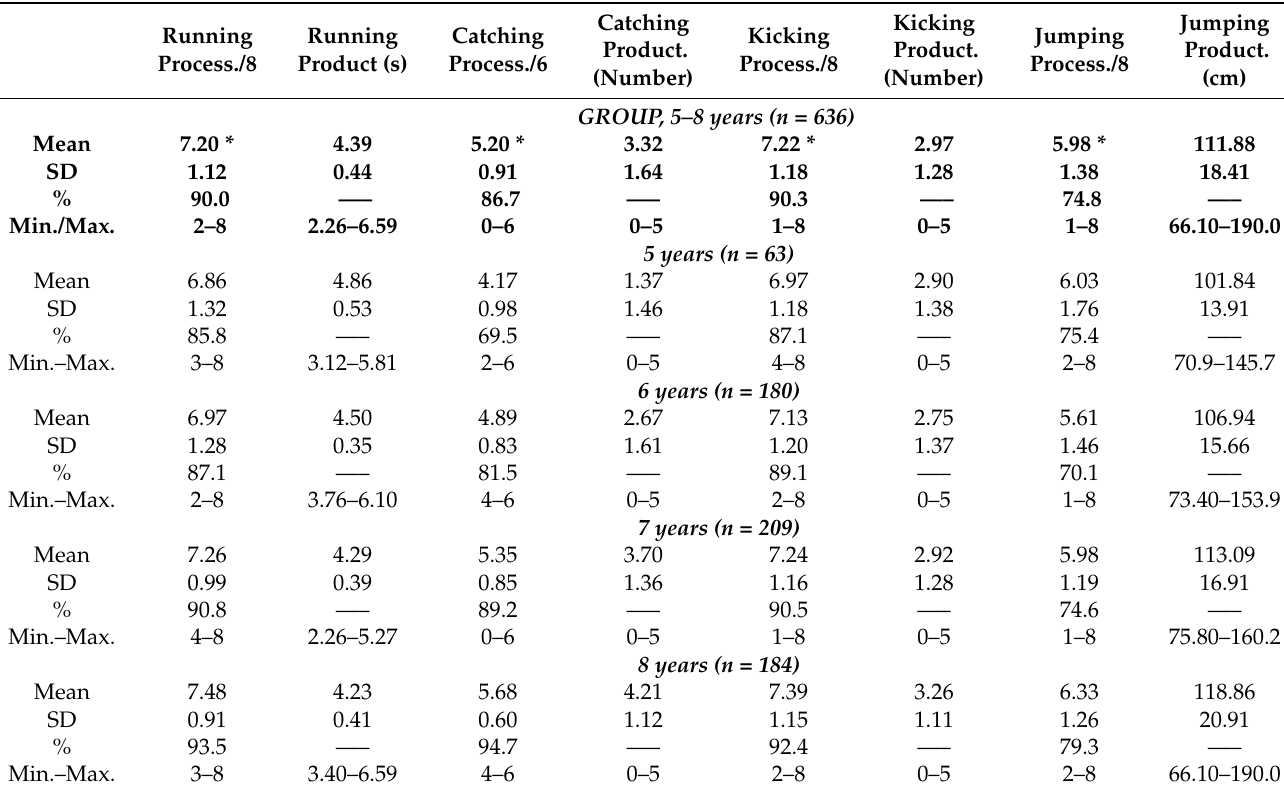
Table 1. Process and product performance of FMS among five to eight-year-olds, per age